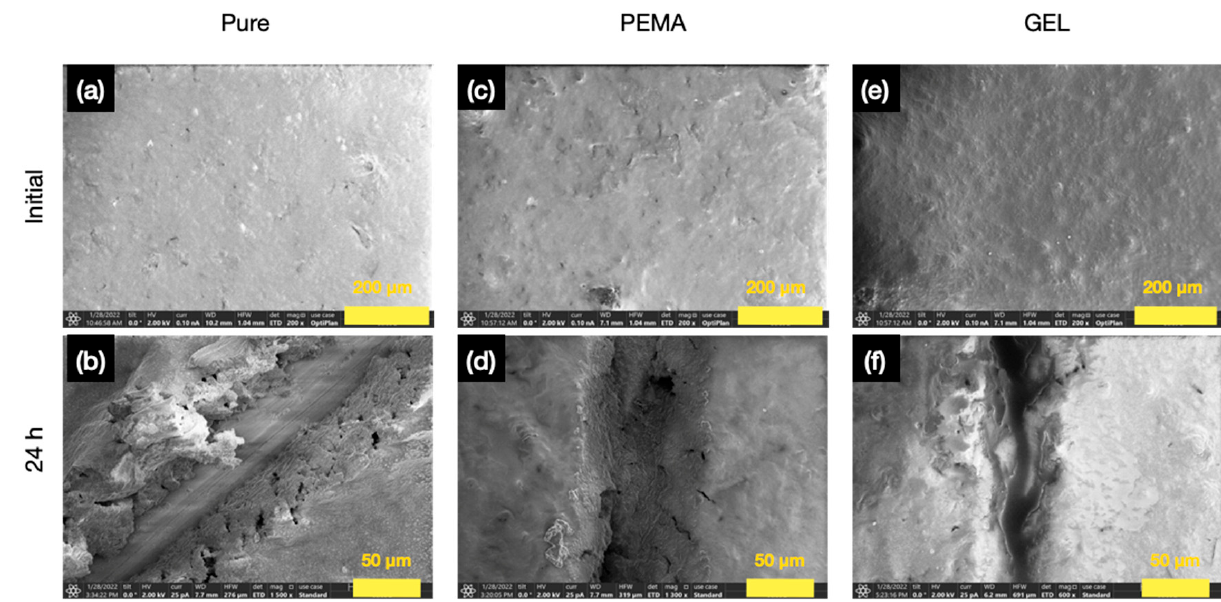
Figure 11. ( a ) Initial scratch for the pure epoxy primer, ( b ) 24 h after scratching the pure epoxy primer, ( c ) initial scratch for the 5 wt. % PEMA embedded epoxy primer, ( d ) 24 h after scratching the 5 wt. % PEMA embedded epoxy primer, ( e ) initial scratch for the 5 wt. % GEL embedded primer, ( f ) 24 h after scratching the the 5 wt. % GEL embedded primer.